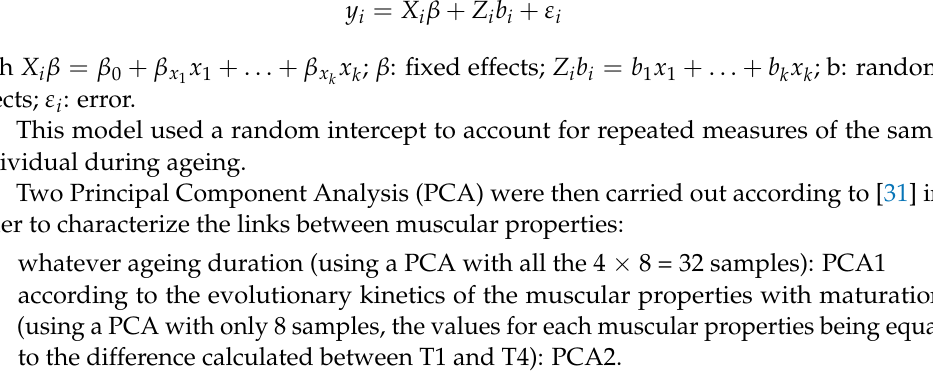
Figure 2. pH evolution with ageing time. T1, T2, T3 and T4 correspond with the different ageing length (respectively 7, 16, 35 and 60 days). Box ‐ plot explanation: the central value represents the median; the edges of the rectangle are the quartiles and the extremities are calculated using 1.5 times the inter ‐ quartile range. a, b, c, d: significant differences ( p < 0,05). Table 2. DM and pH values for each ageing duration. T1